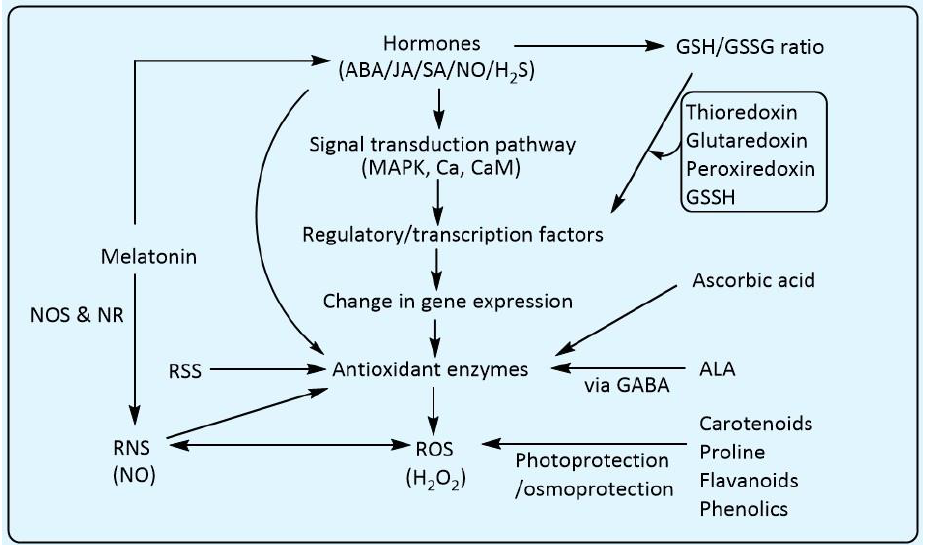
Figure 6. A schematic diagram of cross-talking species during functioning of antioxidant enzymes to mitigate the reactive oxygen species (ROS). Abbreviations: Abscisic acid (ABA), Jasmonic acid (JA), Salicylic acid (SA), Nitric Oxide (NO), Hydrogen sulphide (H 2 S), Mitogen-Activated Protein Kinase (MAPK), Calcium (Ca), Calmodulin (CaM), Reactive Sulphur Species (RSS), Reaction Nitrogen Species (RNS), Nitric Oxide Synthase (NOS), Nitrate Reductase (NR), 5-Aminolevulinic acid (ALA), Gamma-Amino Butyric Acid (GABA).